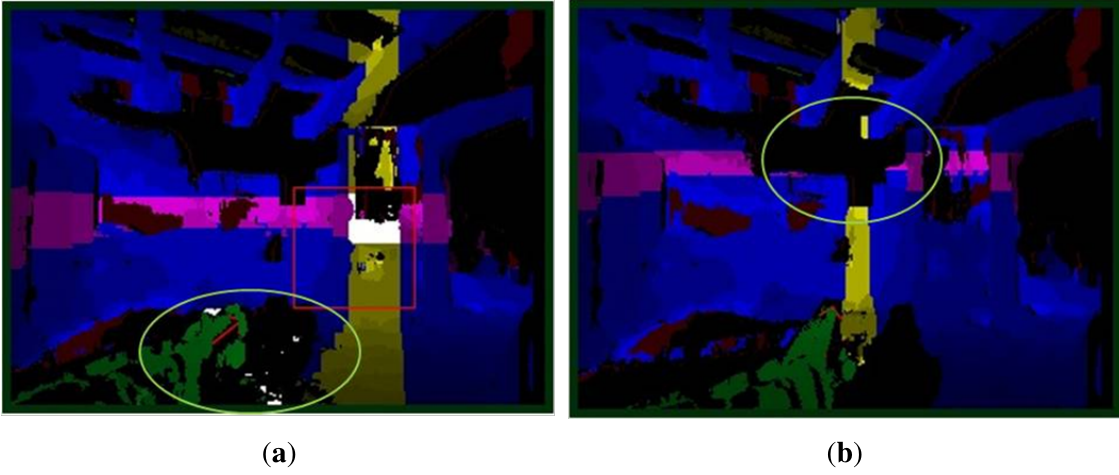
Figure 6. Examples of ( a ) noisy disparity data and ( b ) lack of disparity values. Those areas are highlighted by ellipsoids.